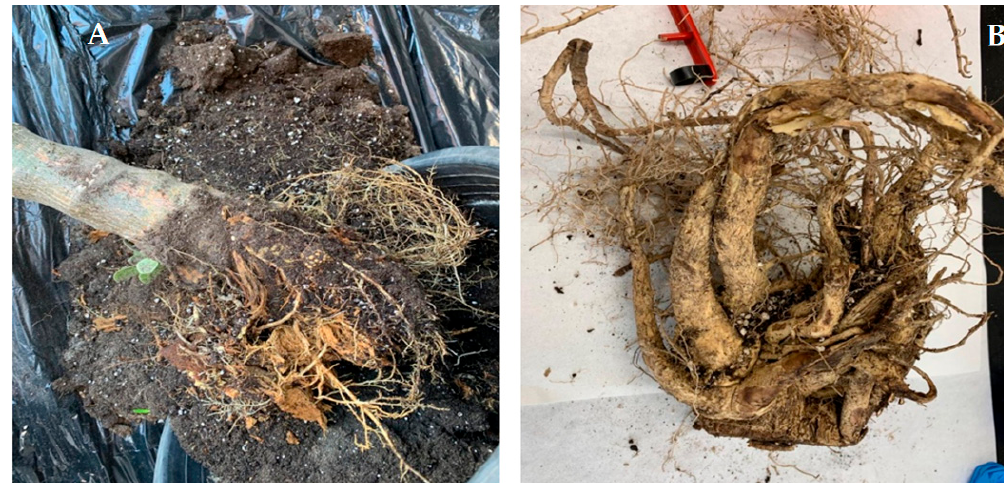
Figure 5. J. curcas L. roots from plants grown in NCS (A) and in CS (B) after 90 days.